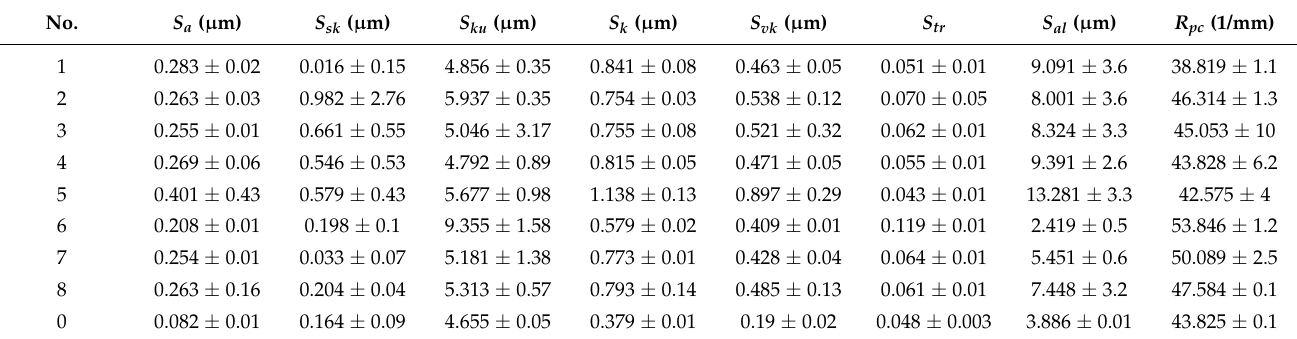
Table 3. Surface roughness parameters of microstructural surfaces measured before